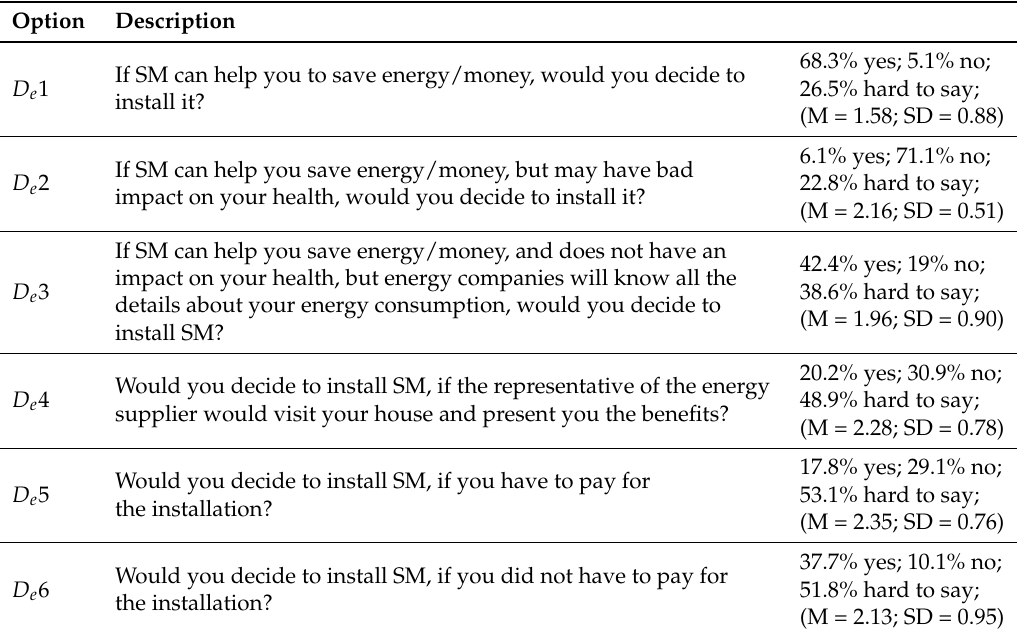
Table 3. Willingness to accept/install SM (Notation: (1) yes, (2) no (3) hard to